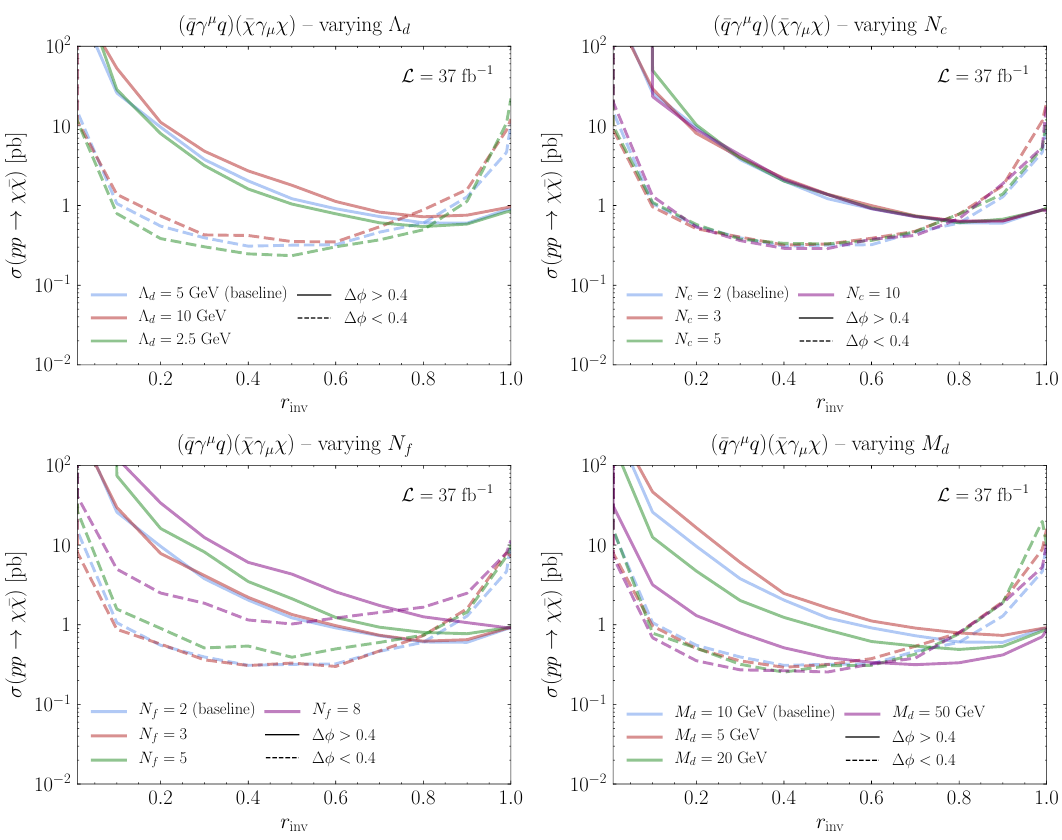
Figure 14 . This (cid:12)gure shows that there is little variation in the limits on the cross section, assuming the contact operator approximation, when changing the detailed properties of the dark